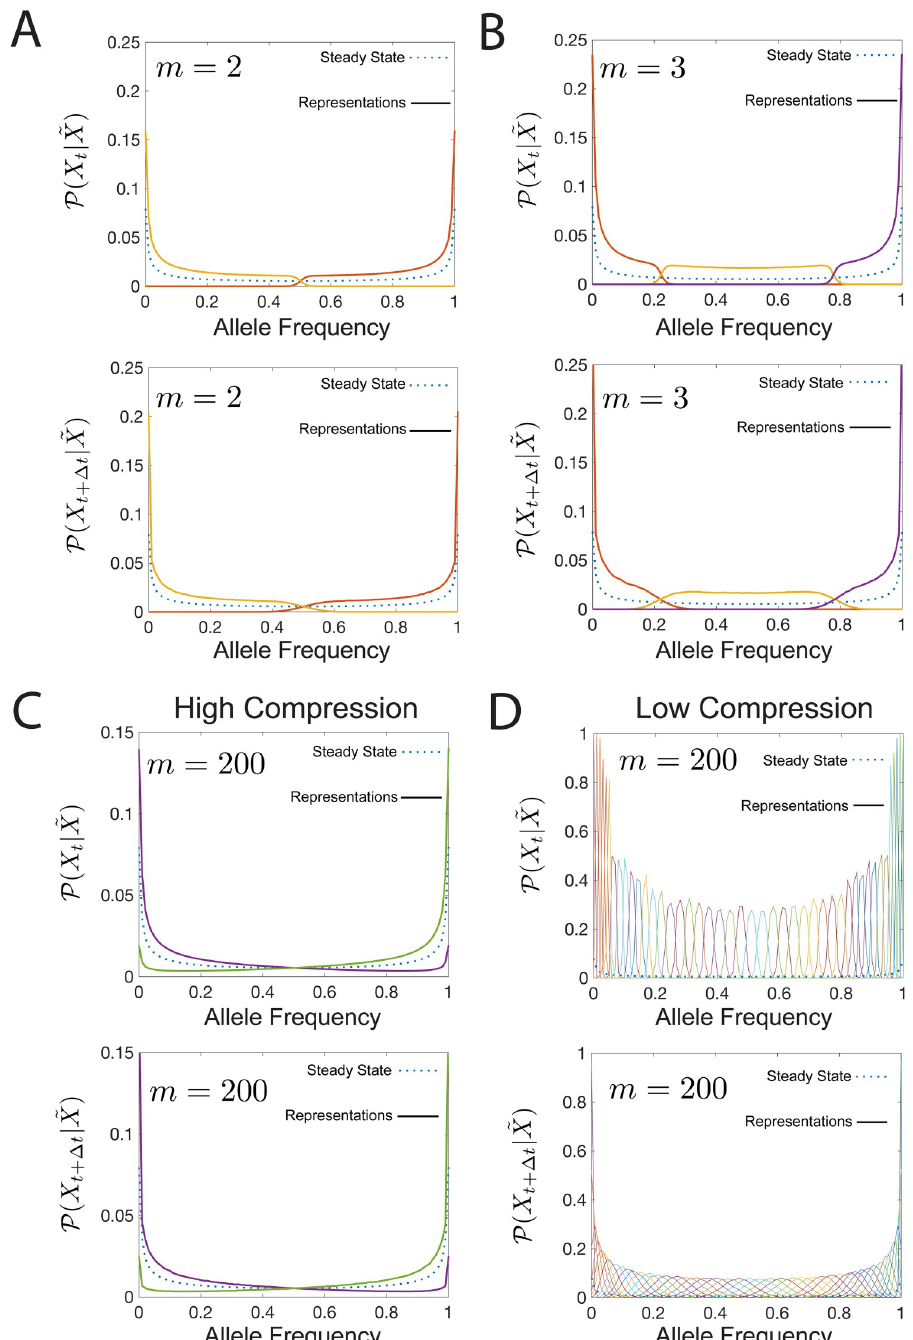
Fig 11. Encoding schemes with m > 2 representation variables. The steady state is plotted as a dotted line and the representation for each realization of the value of ~ X are plotted as solid lines. The representations which carry ; ~ X Þ � log ð m Þ ¼ 1 bit, and (b) m = 3 at I ð X ; ~ X Þ � log ð m Þ � 1 : 5 maximum predictive information for (a) m = 2 at I ð X t t bits. The optimal representations at large m tile space more finely and have higher predictive information. The optimal representations for m = 200 at fixed β = 1.01 ( I ð X ; ~ X Þ ¼ 0 : 28 , I ð X ; ~ X Þ ¼ 0 : 27 ) (c) and β = 20 ( I ð X ; ~ X Þ ¼ 2 : 77 , t t þ D t t ; ~ X Þ ¼ 2 : 34 ). (d) At low I ð X ; ~ X Þ , many of the representations are redundant and do not confer more predictive I ð X t þ D t t information than the m = 2 scheme. A more explicit comparison is given in S3 Fig. At high I ð X ; ~ X Þ , the degeneracy is t lifted. All computations done at N = 100, Nμ = 0.2, Ns = 0.001, Δ t =